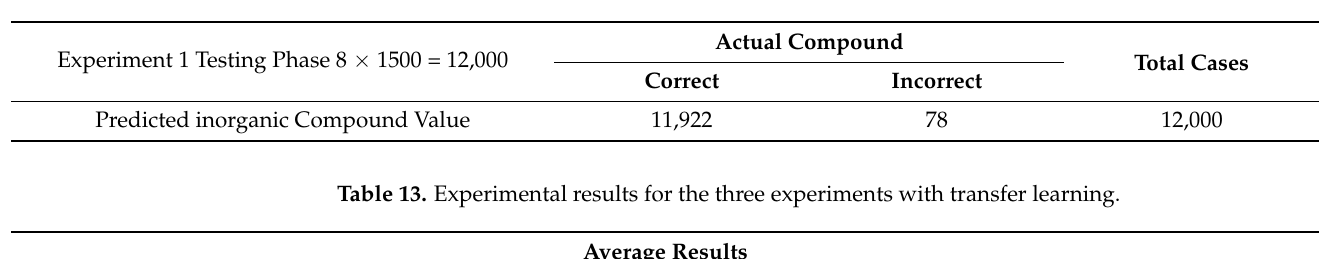
Table 12. Experiment 3 confusion matrix for the proposed CNN with the transfer learning using DS1 eightfold testing and (Map EE&VOL ) as input for training.